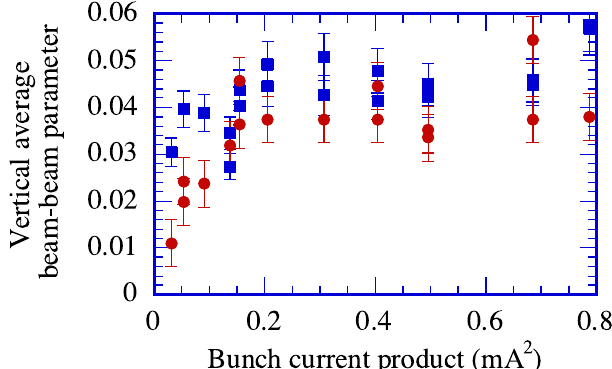
FIG. 8. (Color) Vertical average beam-beam parameter as a function of the product of bunch currents. The red dots represent the average coherent beam-beam parameter estimated from the tune shift, and the blue squares represent the beam-beam pa- rameter estimated from the luminosity